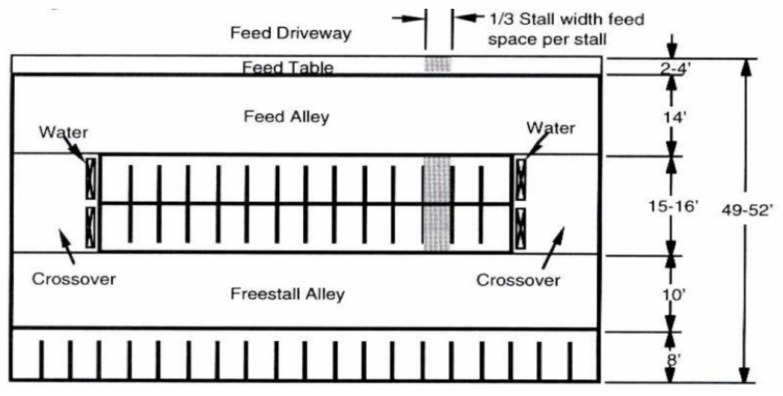
Figure 3. Housing module: schematic representation of one section in the stall. Sources: Samer